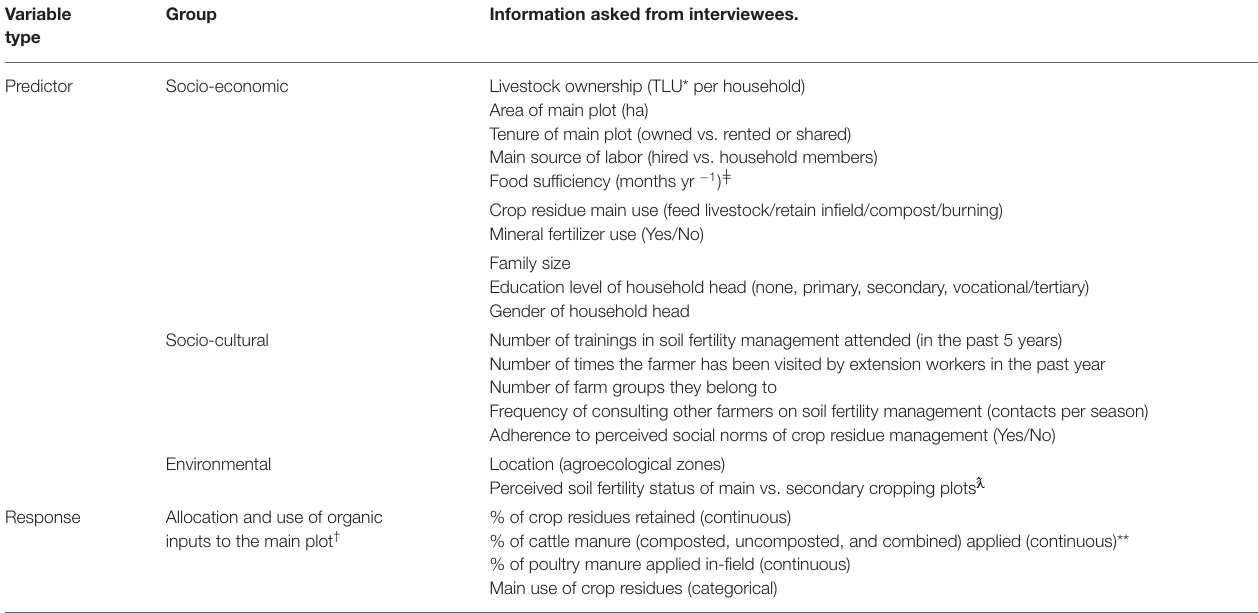
TABLE 4 | Dependent and predictor variables that were used for stepwise regression and stepwise multinomial logistic regression. Variable type